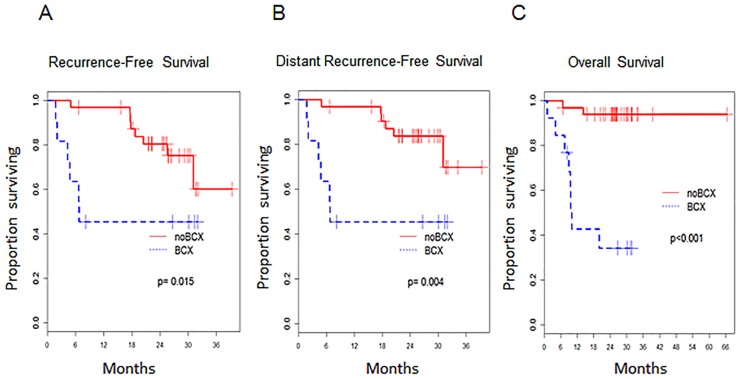
Survival Outcomes in Patients Based on BCX development.(A) Recurrence-free survival (in months) in patients whose tumors developed BCX versus those did not (no BCX). (B) Distant recurrence-free survival (in months) in patients whose tumors developed BCX versus those did not (no BCX). (C) Overall survival (in months) in patients whose tumors developed BCX versus those did not (no BCX).